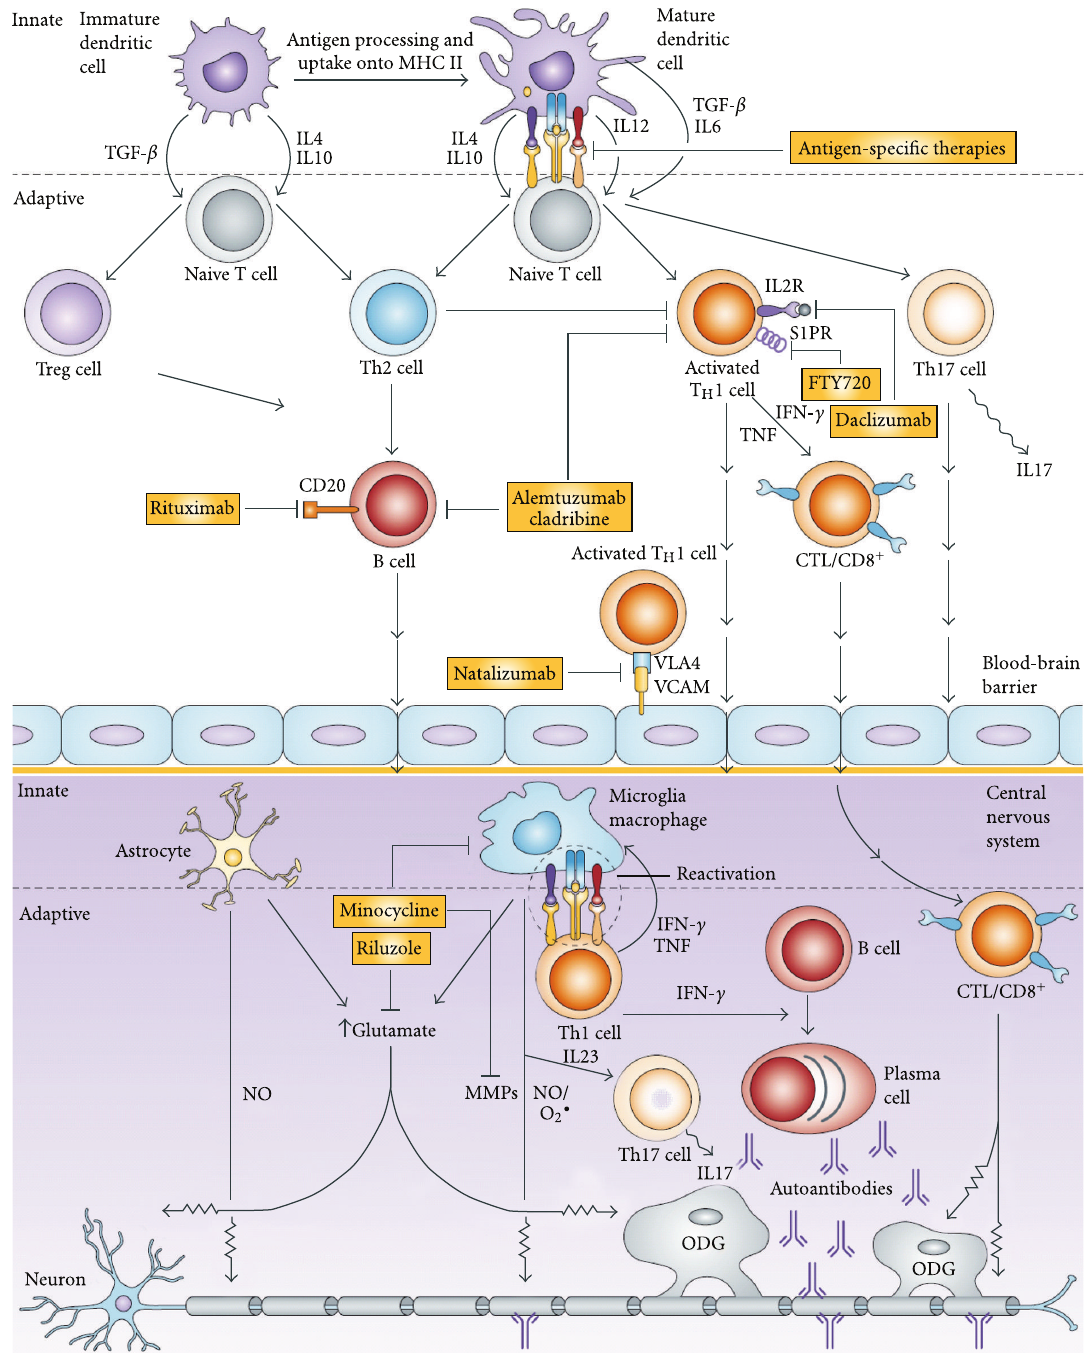
Figure 2: Multiple sclerosis immunopathogenesis and therapeutic targets. Immature dendritic cells (DCs) are central players in the innate immune response and are involved in the maintenance of peripheral tolerance by promoting the suppressor Treg and anti-inflammatory Th2- cell responses. Abnormally activated (mature) antigen-presenting DCs can be found in patients with multiple sclerosis (MS). This activation results in the increased production of proinflammatory cytokines, which lead to the aberrant activation of Th1 and Th17 proinflammatory responses. Activated encephalitogenic adaptive immune e ff ectors (such as Th1 cells, Th17 cells, CD8 + cells, and B cells) express surface molecules that allow them to penetrate the blood-brain barrier and to enter the central nervous system (CNS). The presence of autoreactive immune e ff ectors, together with abnormally activated CNS astrocytes and microglia, leads to the increased production of reactive oxygen species, excitotoxicity, autoantibody production, and direct cytotoxicity, which are all involved in the demyelination and axonal and neuronal damage that is present in patients with MS. Potential therapeutic interventions at di ff erent levels of the immunopathological cascade are shown in the filled yellow boxes (cytotoxic T lymphocytes [CTL]; interferon γ [IFN γ ]; IL2 receptor [IL2R]; major histocompatibility complex class II [MHC II]; matrix metalloproteinases [MMPs]; nitric oxide [NO]; oligodendrocyte [ODG]; sphingosine 1-phosphate receptor [S1PR]; transforming growth factor β [TGF β ]; tumor necrosis factor [TNF]; regulatory T cells [Treg]; vascular cellular adhesion molecule 1 [VCAM1]; very late antigen 4 [VLA-4] (This figure was adapted and partly revised from